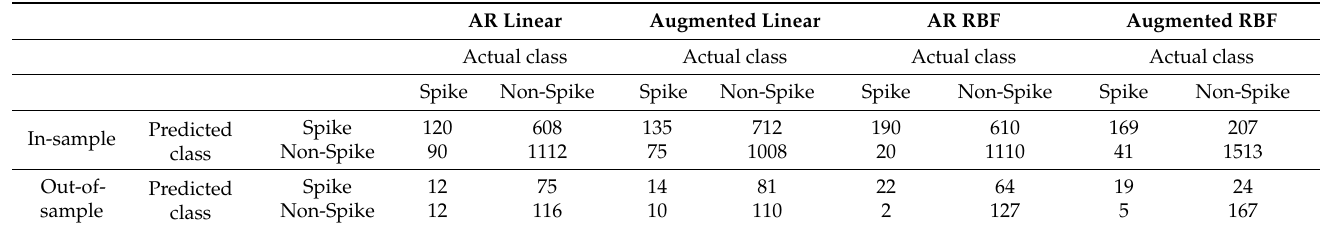
Table 6. Confusion matrix for spikes and